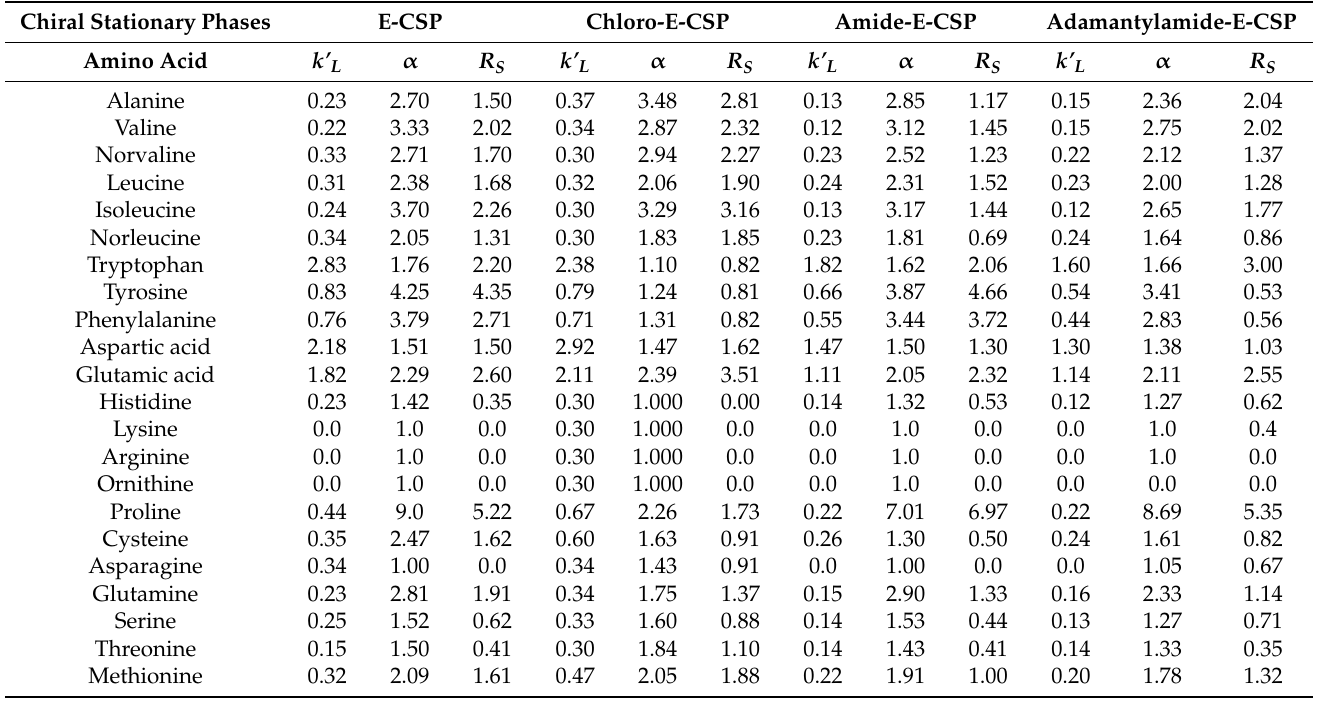
Table 2. Enantioselectivity ( α ) and resolution ( R S ) for amino acids for the studied CSPs, eluent 20%